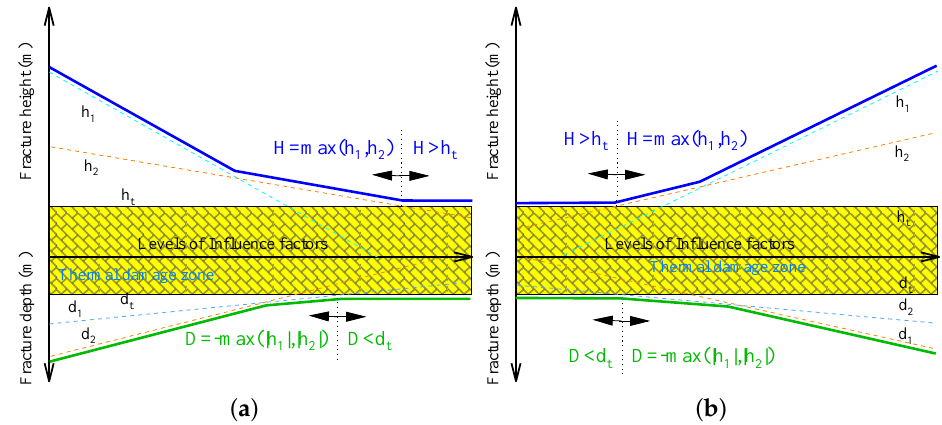
Figure 7. Sketch for determination of the total height and depth of fracture. ( a ) Decreasing tendency; ( b ) Increasing